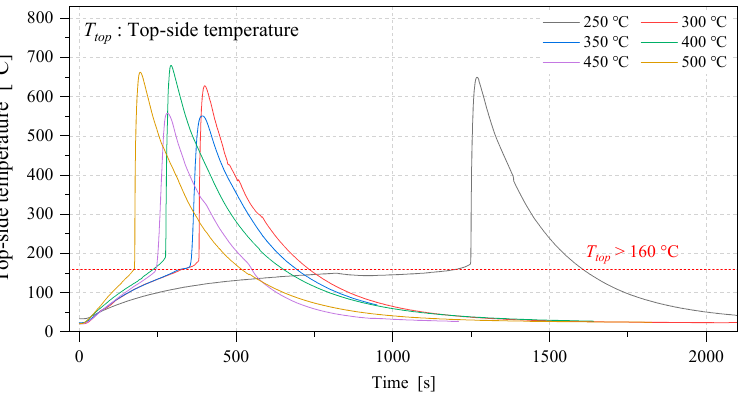
Figure 3. Top-side temperature of a battery cell with variations in plate temperature during thermal runaway of lithium-ion batteries.